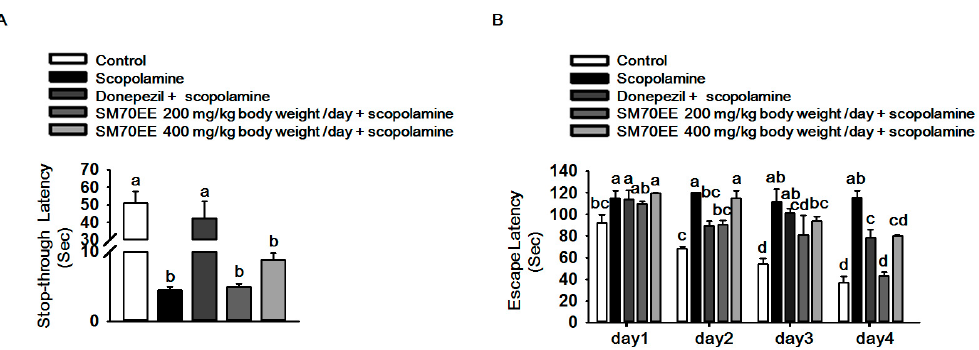
Figure 4. SM70EE prevents learning and memory impairment caused by scopolamine-induced neurotoxicity in mice. ( A ) Mice were subjected to a passive avoidance test; ( B ) Mice were subjected to a Morris water maze test. Results were analyzed by one-way ANOVA and Duncan’s multiple range tests. The p -value in the multiple comparison results (e.g., a, b, c, and d) indicate significant differences among the groups ( p < 0.05).